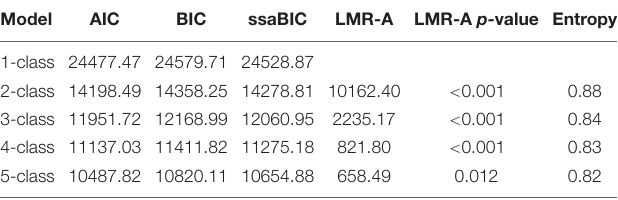
TABLE 2 | Fit of competing latent profile models.